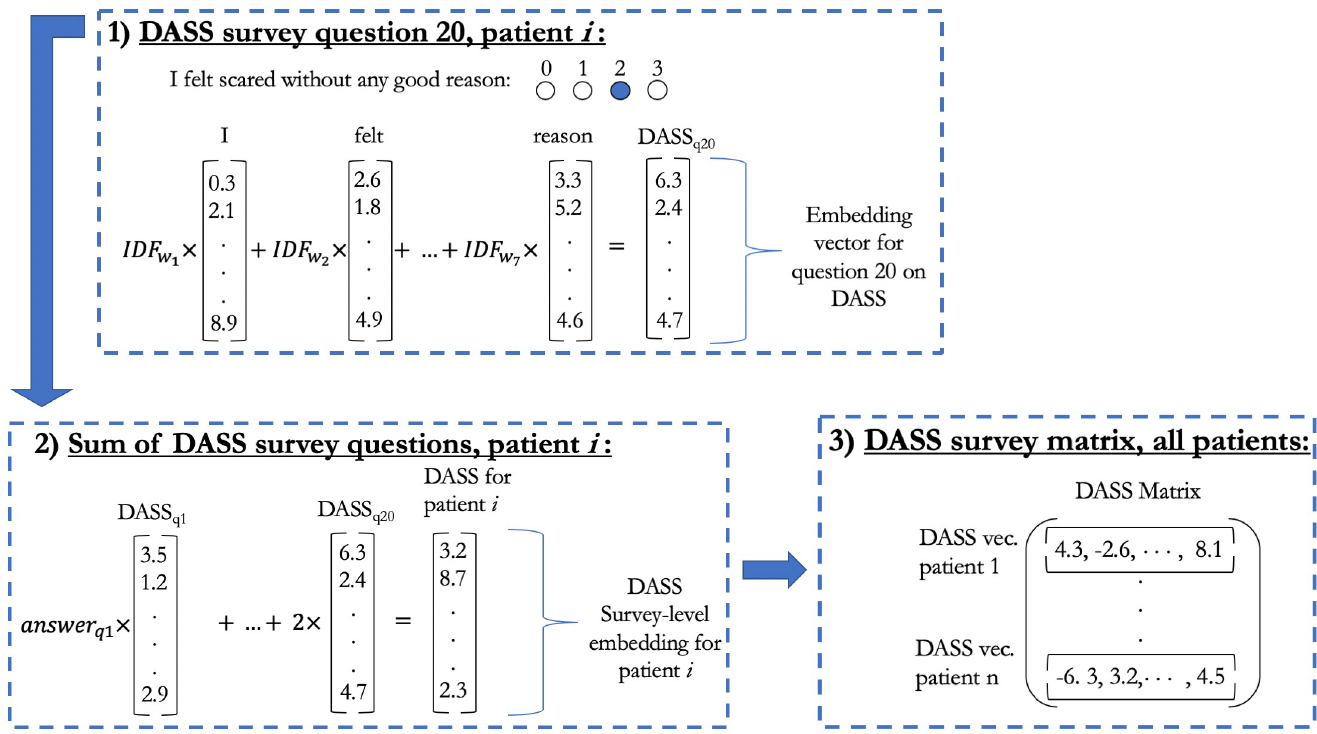
Fig 1. Workflow to compute survey-level embedding matrix. The example is illustrated with the DASS questionnaire and a given patient i response. In Box 1 we illustrate the first step with question 20: “I felt scared without any good reason.” We weight the 500-dimensional embedding vector for each word in the question by its corresponding IDF weight, this yields a question-level embedding vector for question 20 (q20). Subsequently as shown in Box 2 we add all question vectors in the survey, respectively weighted by the patient’s i answers. In this example, answer to q20 was “2,” thus we multiply the last question embedding by 2. The result is a survey-level embedding vector for DASS for patient i. We repeat the process with DASS for all patients i = 1 , ... , 310 , concatenating the transposed survey-level vectors as shown in Box 3. Finally, we have a questionnaire-level matrix of dimension 310 x 500, corresponding to patient by embedding dimension.